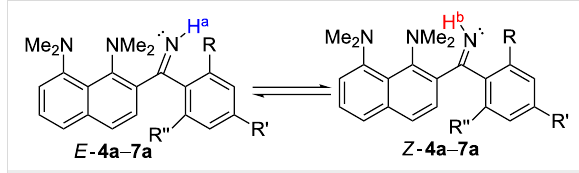
Scheme 6: E/Z -Isomerisation of ketimines 4a – 7a